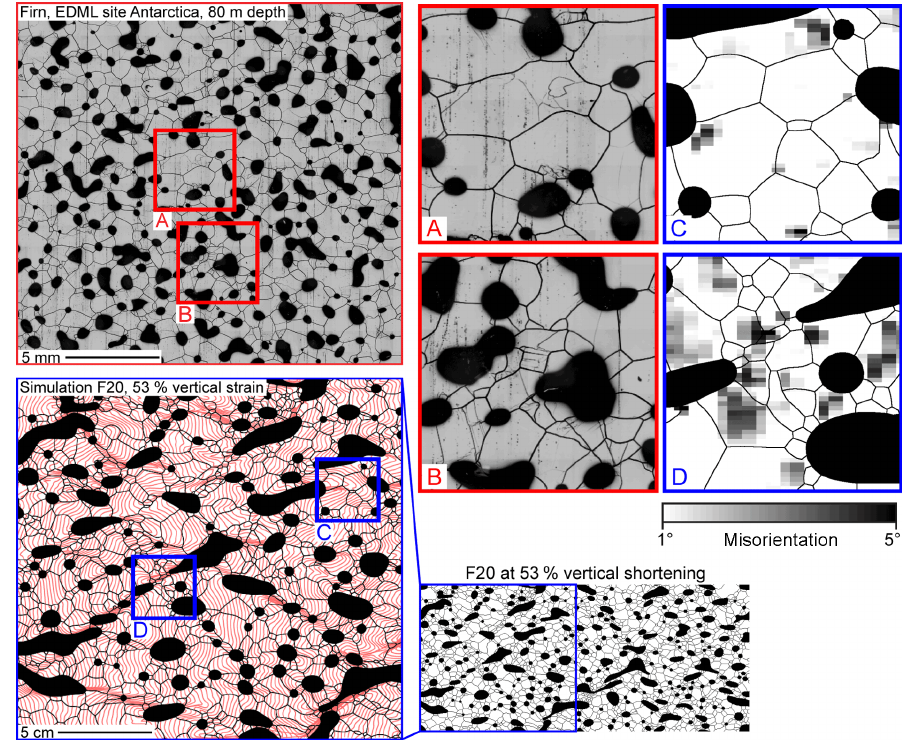
Figure 8. Comparison of simulation results of F20 at 53% vertical shortening with firn microstructure mapping images from the EDML ice core site at 80m depth (courtesy of Sepp Kipfstuhl). The detail areas A–D illustrate different microstructures occurring in relation to strain localization. Grain boundaries stand out as black lines and subgrain boundaries are visible as fainter grey lines. Vertical stripes appearing in the overview image are related to the sample polishing technique and not reflecting any microstructural property. Greyscales C and D indicate local average misorientations as stored in unodes and therefore appear blurred due to the strong magnification. Note, however, that strain paths of the natural microstructure (compaction) and the simulation (pure shear) are not identical and the comparison is restricted to the microstructural similarities and inferred localization and recrystallization